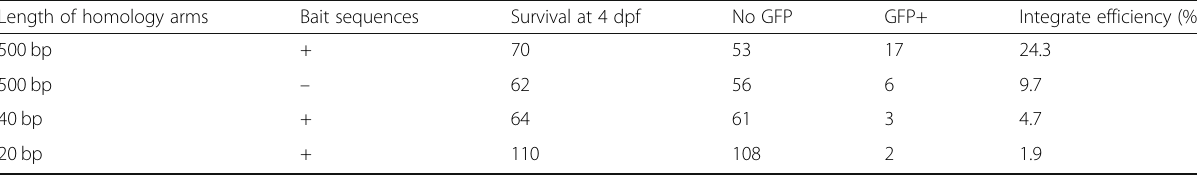
Table 1 Comparison of integrate efficiency among each of donor plasmids Length of homology